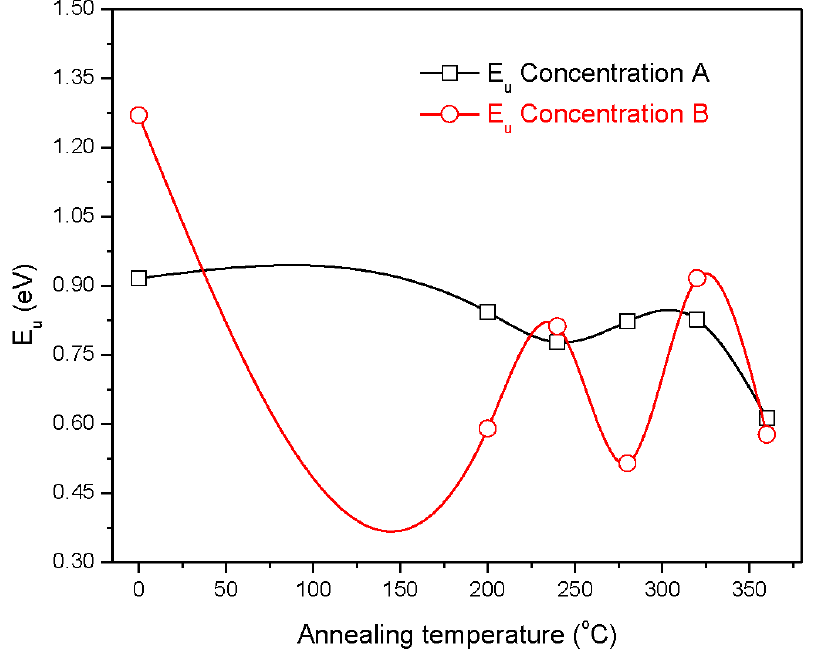
Figure 11. Variation of Urbach energy ( E A and